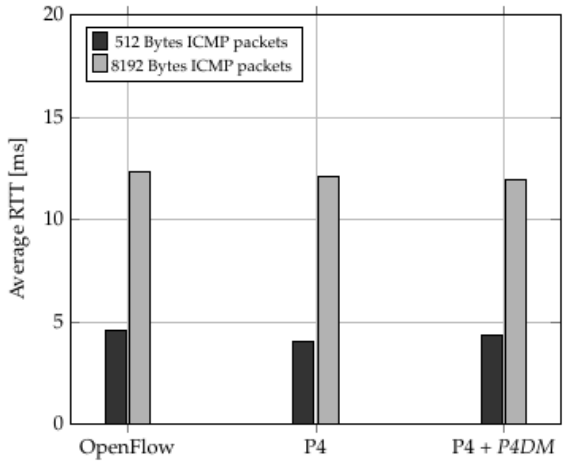
Figure 11. Protocol enabled switches RTT